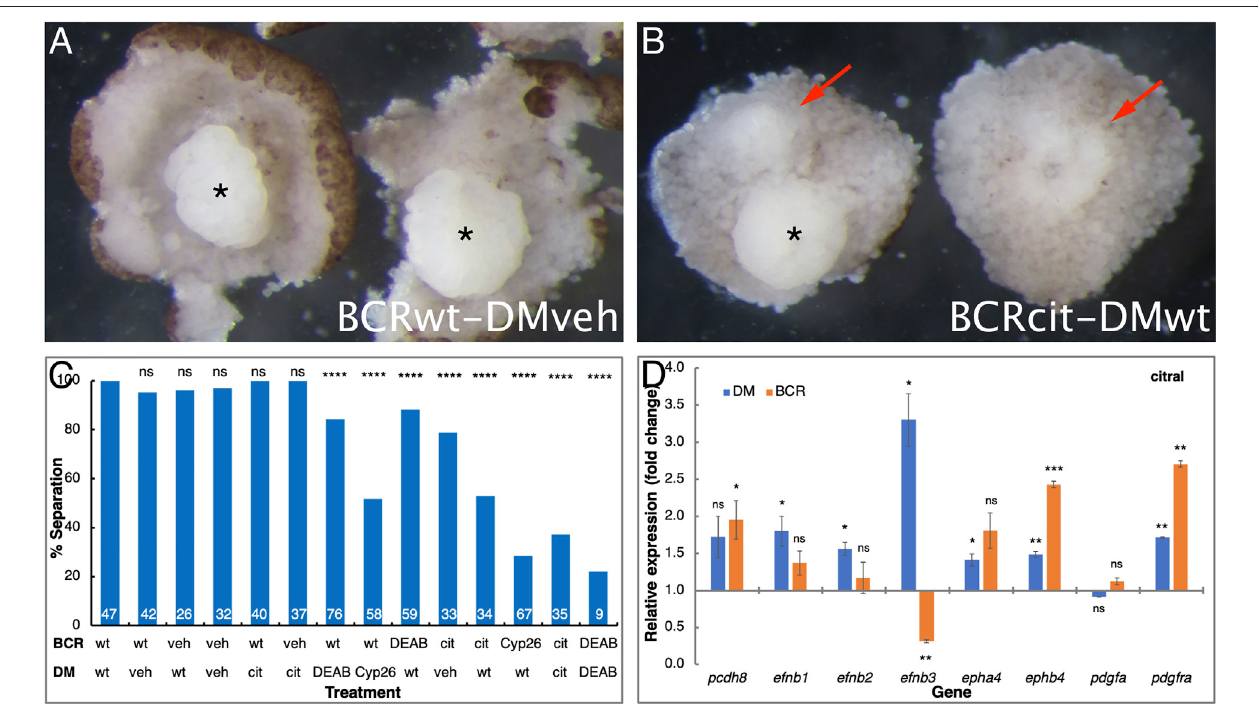
FIGURE 7 | RA regulates the tissue separation behavior across Brachet ’ s cleft. Embryos were manipulated to reduce RA signaling levels by treatment with DEAB, citral,orinjectedwithmRNAencodingCYP26A1.Forcontrols,embryosweretreatedwiththediluentalone(veh)fortheDEABorcitraldilutionsorleftuntreated(wt).The explantedBCRorDM regions wereanalyzed separatelyor conjugated fortheseparationbehaviorassay. (A) Control examples ofseparation behaviorassay conjugates between control (wt) BCR and vehicle (veh) treated DM (asterisk). (B) Loss of separation behavior (arrows) when control DM was placed onto BCR treated with citral. * indicates a DM that did remain separated. (C) The extent of separation behavior (%) in all the assays performed in all combinations. # separation/# total: 47/47 DMwt/BCRwt; 40/42 DMveh/BCRwt; 25/26 DMwt/BCRveh; 31/32 DMveh/BCRveh; 40/40 DMcit/BCRwt; 37/37 DMcit/BCRveh; 64/76 DMDEAB/BCRwt; 30/58 DMCyp26/BCRwt;52/59DMwt/BCRDEAB;26/33DMveh/BCRcit;18/34Dmwt/BCRcit;19/67DMwt/BCRCyp26;13/35DMcit/BCRcit;2/9DMDEAB/BCRDEAB. (D) qPCR analysisof pcdh8 , efnb1 , efnb2 , efnb3 , epha4 , ephb4 , pdgfa , and pdgfra geneexpression changesin theDMand BCRfollowingcitral treatment. **, p < 0.01; ***, p < 0.001; ****, p < 0.0001; ns, not signi fi